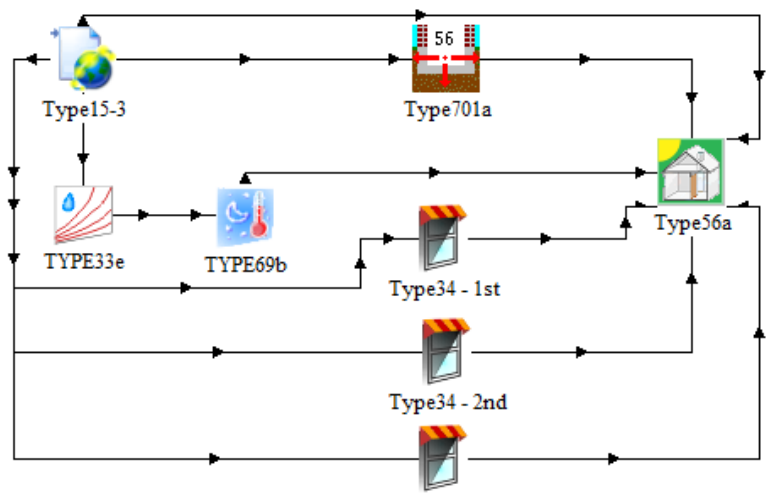
Figure 3. Weather data